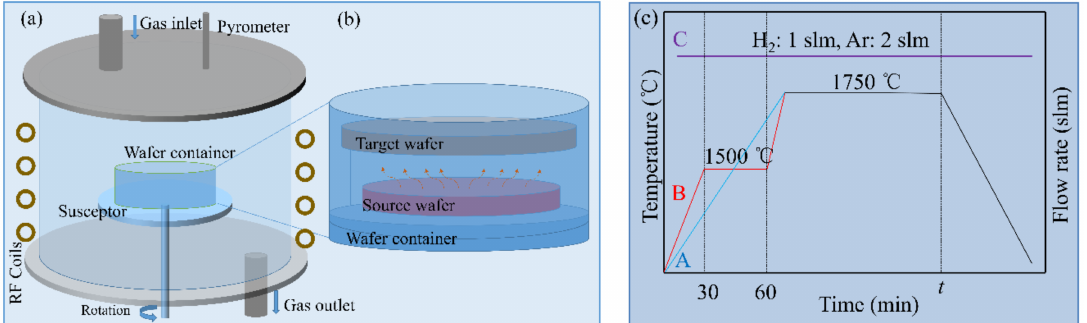
Figure 1. Schematic illustration of ( a ) sublimation epitaxy chamber and ( b ) wafer container with source wafer and target wafer loaded; ( c ) growth